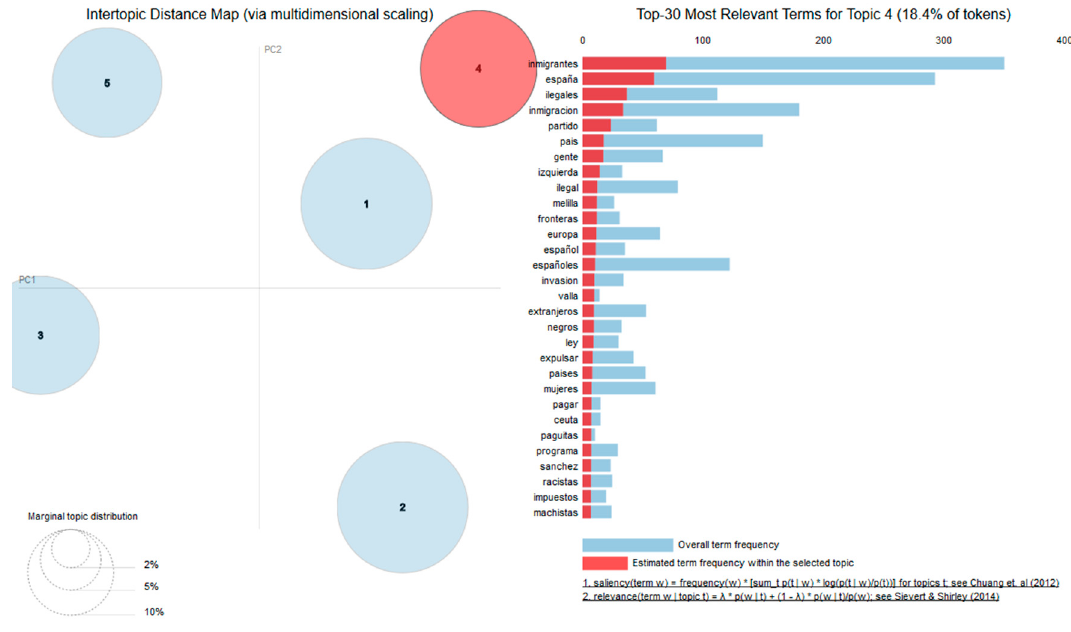
Figure 7. Interactive map of topic 4, ƛ = 1.